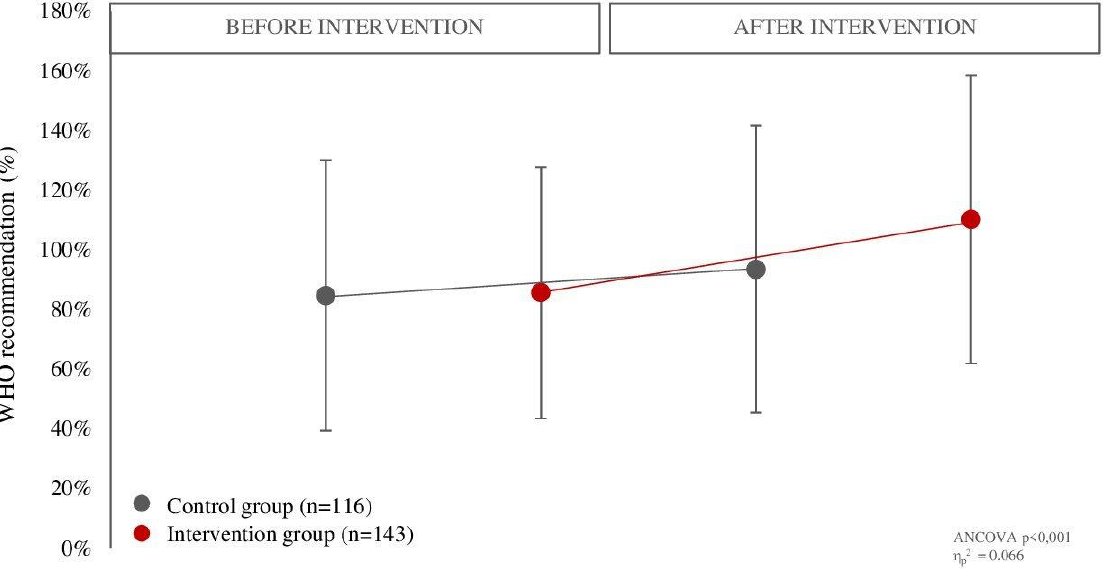
Figure 3. Comparison of the proportion in which children met the recommendations for the daily fruit and vegetable intake between the control and intervention groups before and after the intervention. Variable are presented as mean ± standard deviation. Difference between groups was tested using two-way ANCOVA with repeated measures adjusted for participation in school garden education ( p < 0.05).